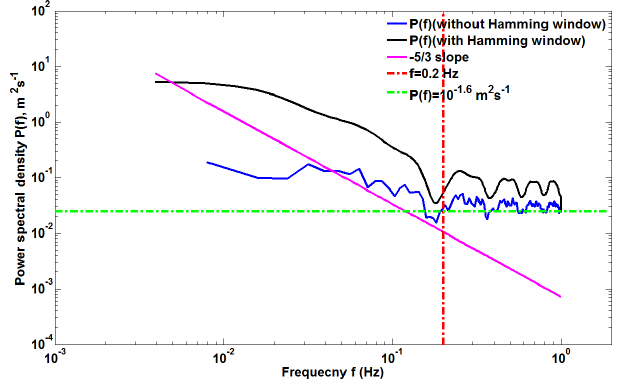
Figure 13. Power spectrum density P(f ) with and without a Ham- ming window for the CDL measured vertical speed, between 15:52 and 16:02LT on 9 May and for an altitude of 1495m (blue and black solid line, respectively). The expected spectrum behaviour ac- cording to the Kolmogorov’s − 5 / 3 law (pink solid line), the noise frequency threshold (red dotted line), and the derived noise floor for the CDL ( green dotted line) are